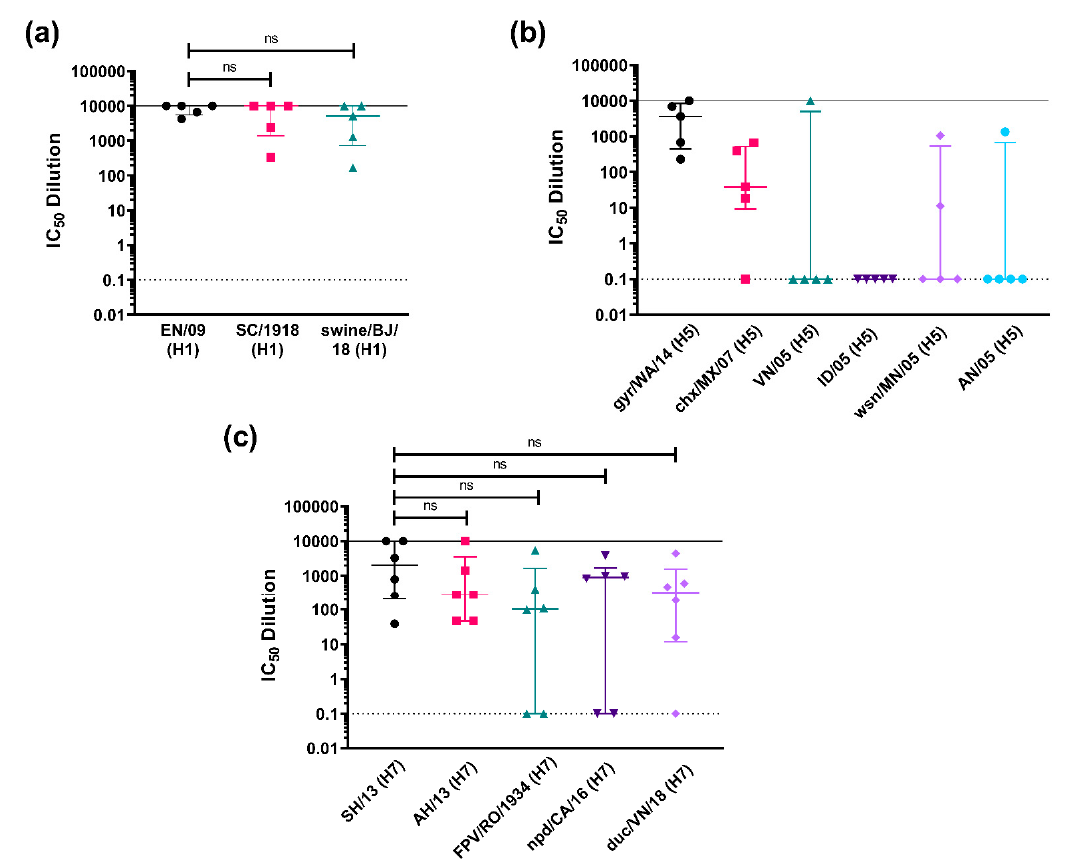
Figure 7. In vitro neutralizing activity as shown by IC 50 dilution of mouse sera vaccinated with an HA subtype tested against homologous PV and representative PV strains of the same subtype. ( a ) Mice were vaccinated with 50 µ g of pEVAC HA A/England/195/09 (H1) (EN/09) ( n = 5). Terminal bleeds (70 dpi) were tested against H1 PV strains (x-axis): homologous EN/09, A/South Carolina/1/1918 (H1) (SC/1918), and A/swine/Beijing/301/18 (H1) (swine/BJ/18). ( b ) Mice were vaccinated with 50 µ g of pEVAC HA A/gyrfalcon/Washington/41088-6/14 (H5) (gyr/WA/14) ( n = 5). Terminal bleeds (70 dpi) were tested against H5 PV strains (x-axis): homologous gyr/WA/14, A/chicken/Mexico/7/07 (H5) (chx/MX/07), A/Indonesia/5/05 (H5) (ID/05), A/Vietnam/1203/04 (H5) (VN/05), A/whooper swan/Mongolia/244/05 (H5) (wsn/MN/05), and A/Anhui/1/05 (H5) (AN/05). ( c ) Mice were vaccinated with 50 µ g of pEVAC HA A/Shanghai/2/13 (H7) (SH/13) ( n = 6). Terminal bleeds (70 dpi) were tested against H7 PV strains (x-axis): homologous SH/13, A/Anhui/1/13 (H7) (AH/13), A/FPV/Rostock/1934 (H7) (FPV/RO/1934), A/northern pintail duck/California/UCD1582/16 (H7) (npd/CA/16), and A/duck/Vietnam/HU10-64/18 (H7) (duc/VN/18). For all plots, the median and interquartile range of individual mouse serum samples per immunization group are shown. The solid line indicates an assigned maximum IC 50 dilution of 10,000 showing 100% neutralization and the broken line shows an assigned baseline level of 0.1 indicating 0% neutralization (cell only mean). Comparisons of no significant difference (ns: p > 0.05) against the homologous PV are shown in